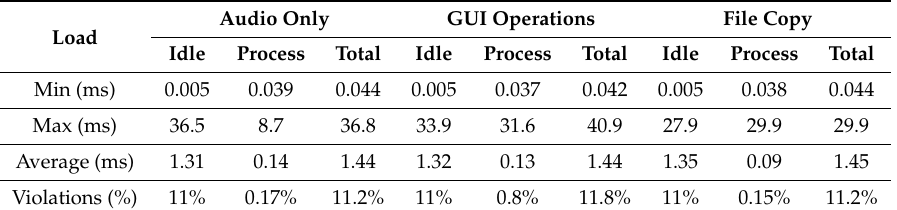
Table 3. Statistics for the voltage-controlled filter running at different OS loads, with audio chunks of 64 samples: audio application only, audio application with I/O operations in the Python GUI, and audio application with copy of a directory tree in background.